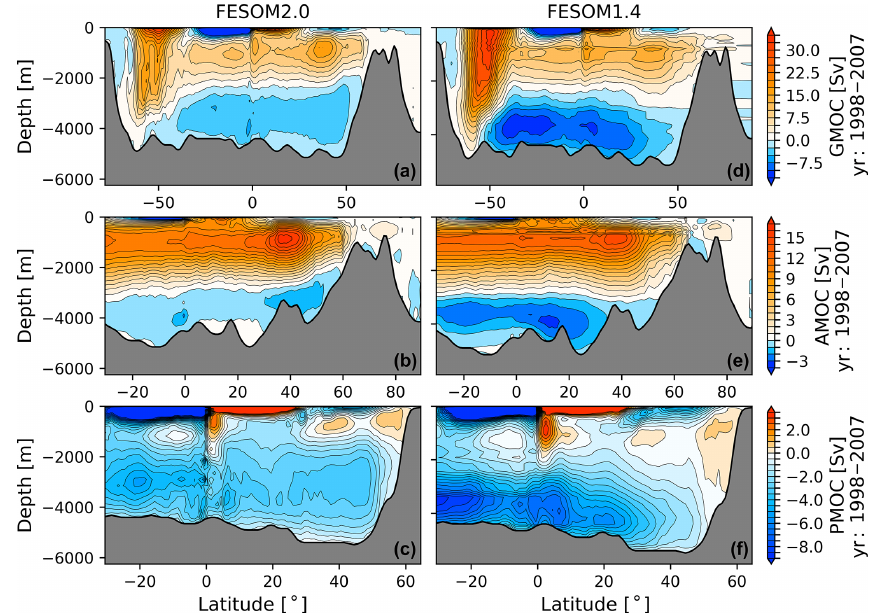
Figure 17. GMOC ( a, d ), AMOC ( b, e ) and PMOC ( c, f ) averaged for the time period of 1998–2007: FESOM2.0 (a–c) and FESOM1.4 (d–f) .